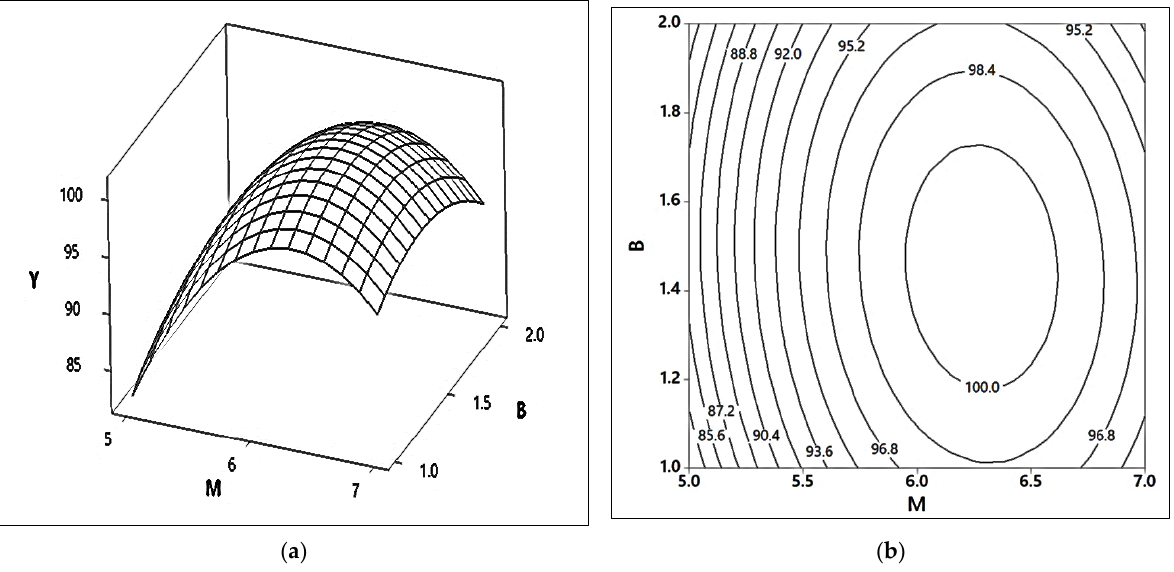
Figure 12. Interaction effect of the methanol to oil molar ratio (M) and KOH catalyst content (B) on the FAME yield (Y) of the transesterification process of WCO. ( a ) A 3D response surface plot of Y (%) vs. M (M) and B (wt.%). ( b ) A 2D contour plot between M (M) and B (wt.%).